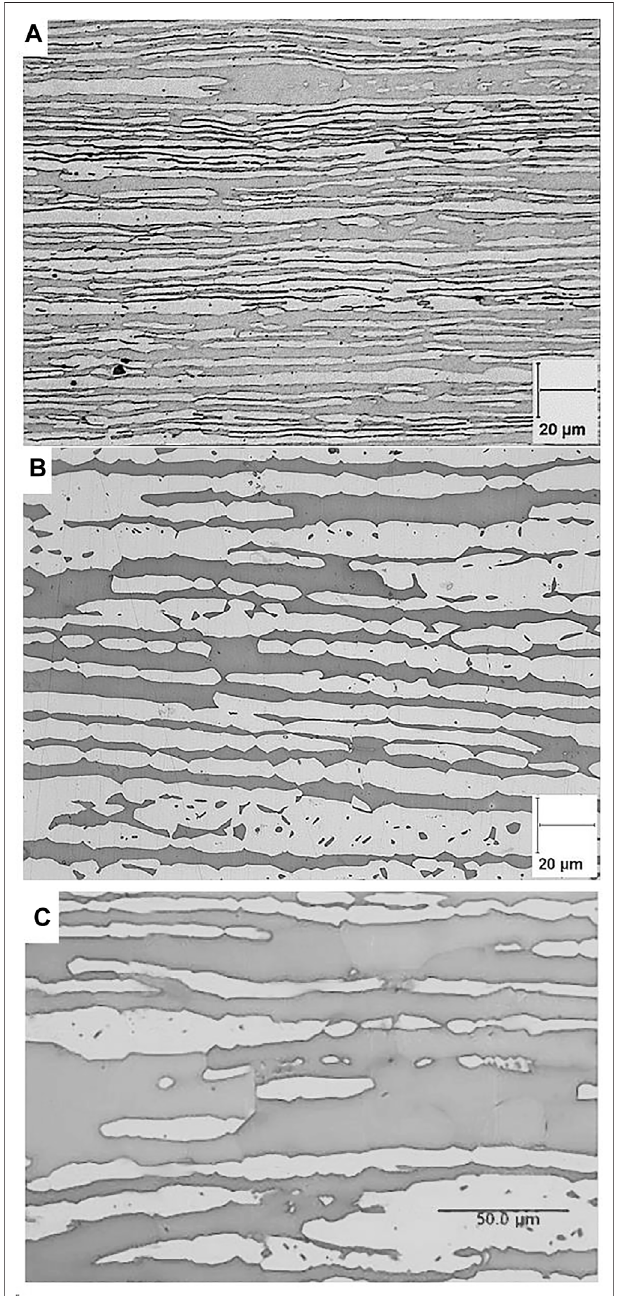
FIGURE 1 | Microstructure of UNS 32750 SDSS alloys (A) thin tube SDSS 1, (B) thin plate SDSS 2, and (C) thick plate SDSS 3. Ferrite phase appears in dark gray and austenite phase in light